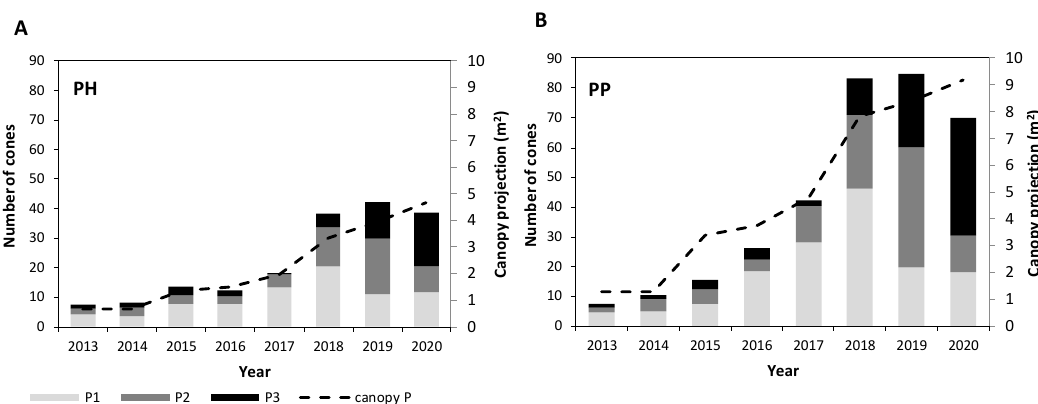
Figure 1. Average of the number of cones per tree (sum of P1, P2 and P3)—columns—and average of the canopy projection (m 2 )—dotted line—from 2013 to 2020. ( A ) P. halepensis rootstock (PH); ( B ) P. pinea rootstock (PP).